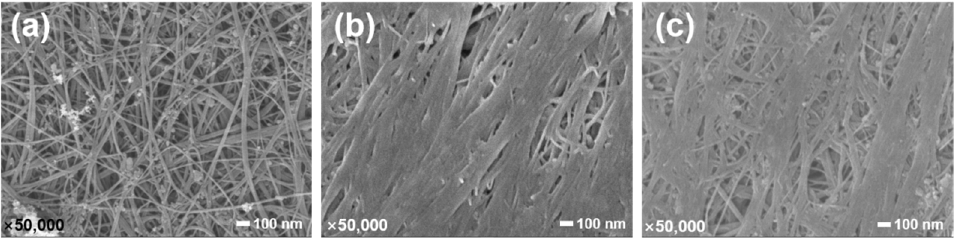
Figure 5. The surface morphology of the pristine CNT film ( a ) and uniaxial ( b ) and biaxial ( c ) stretching samples.